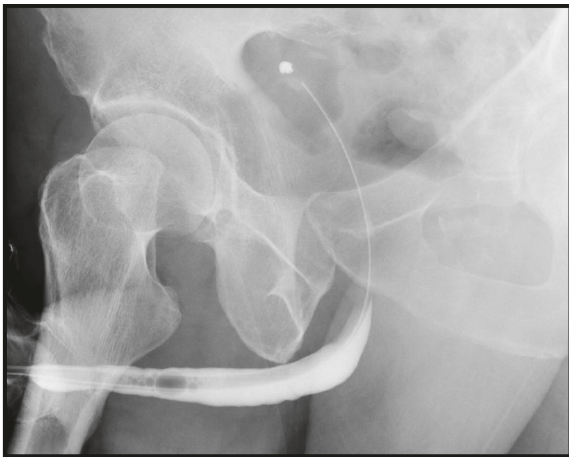
Figure 5: Pericatheter urethrogram showed urethral continuity with no